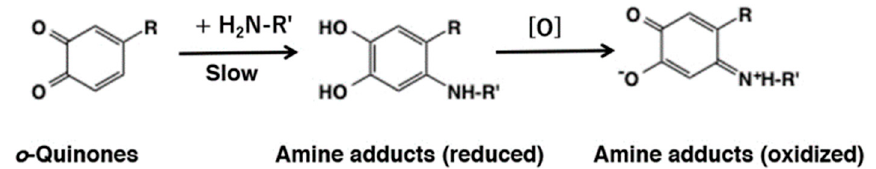
Figure 10. Reaction of o -quinones with amines. Note that the oxidized form of amine adducts are more stable than the reduced form [54].